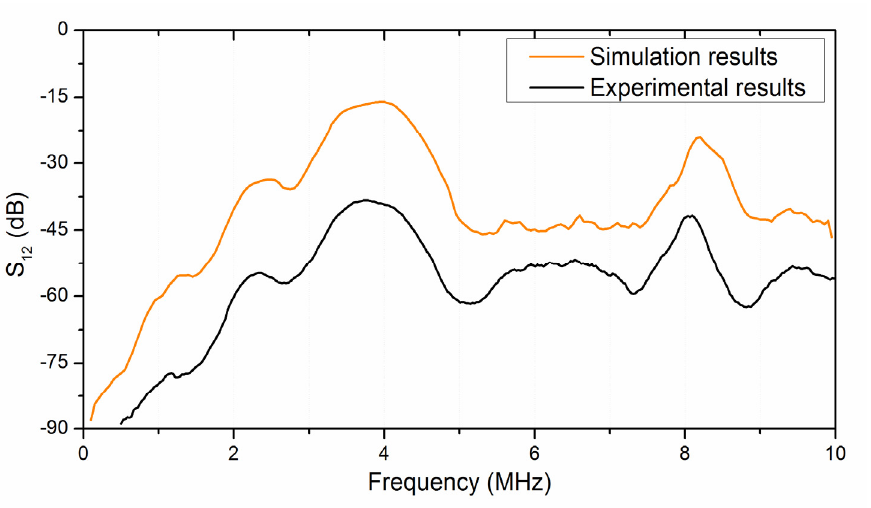
Figure 6. Frequency dependencies of the transmission parameter S 12 (insertion loss) as calculated ( red line ) and measured ( black line ) for the delay line with the focusing IDTs based on the SH 0 wave in the YX LiNbO 3 plate.